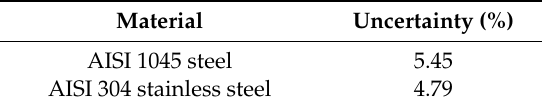
Table 3. Uncertainty values for each analyzed